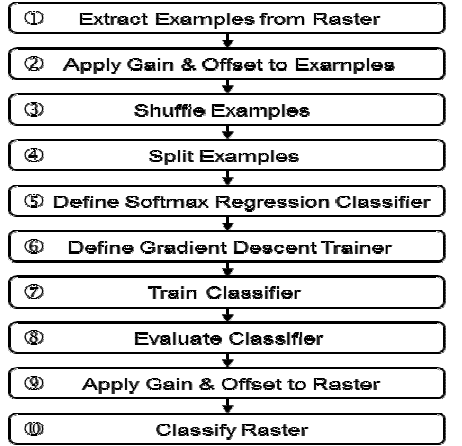
Figure 3. Softmax Regression classification workflow using ENVITasks.